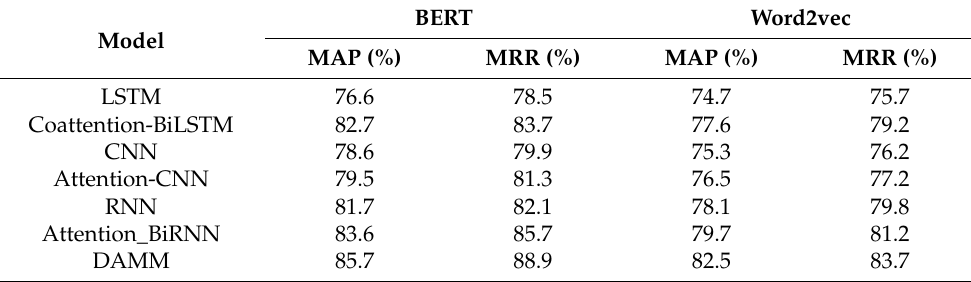
Table 6. Effect of different models on rice-related answer selection dataset.